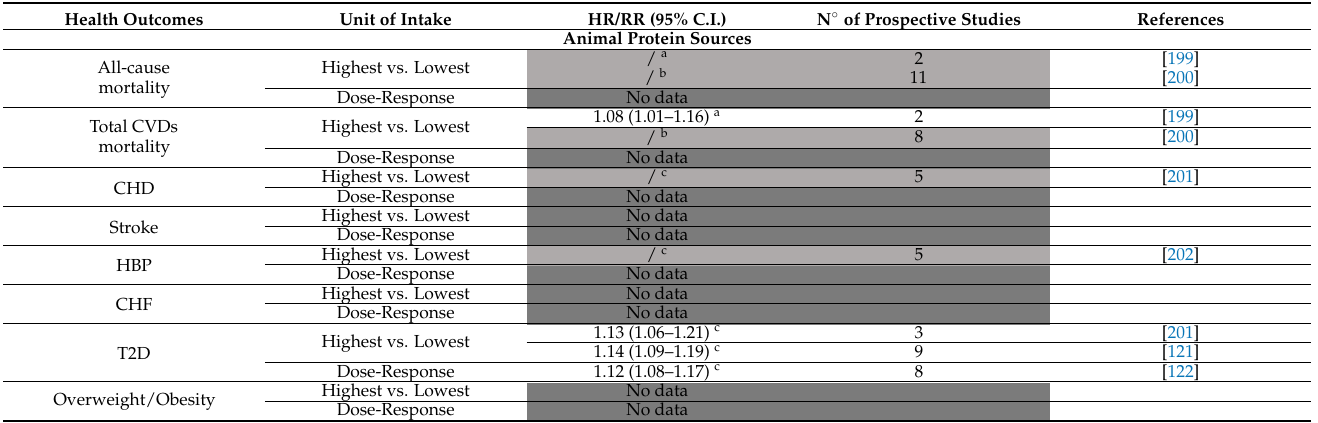
Table 10. Association between intake of animal- and plant-based protein sources and incidences